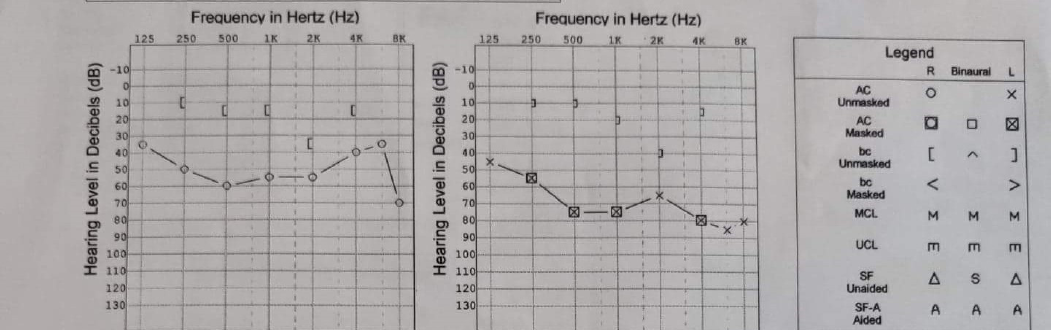
Figure 3. Hearing exam using an Itera II audiometer. Ocular examination BCVA LE (left eye) = 20/25 (+1.50 dsf × − 0.50 dcyl 5 ◦ ) Normal ocular adnexa, normal eye